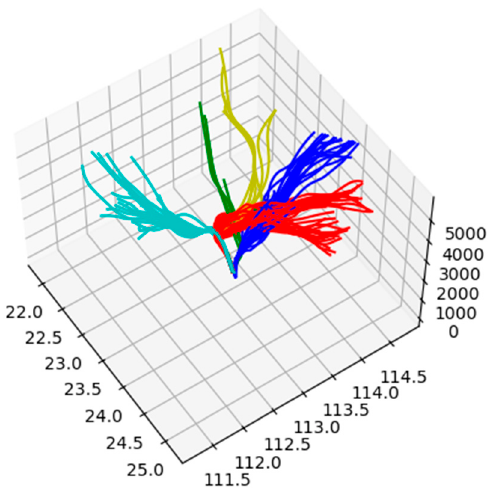
Figure 13. OFAE + DPCA clustering result.